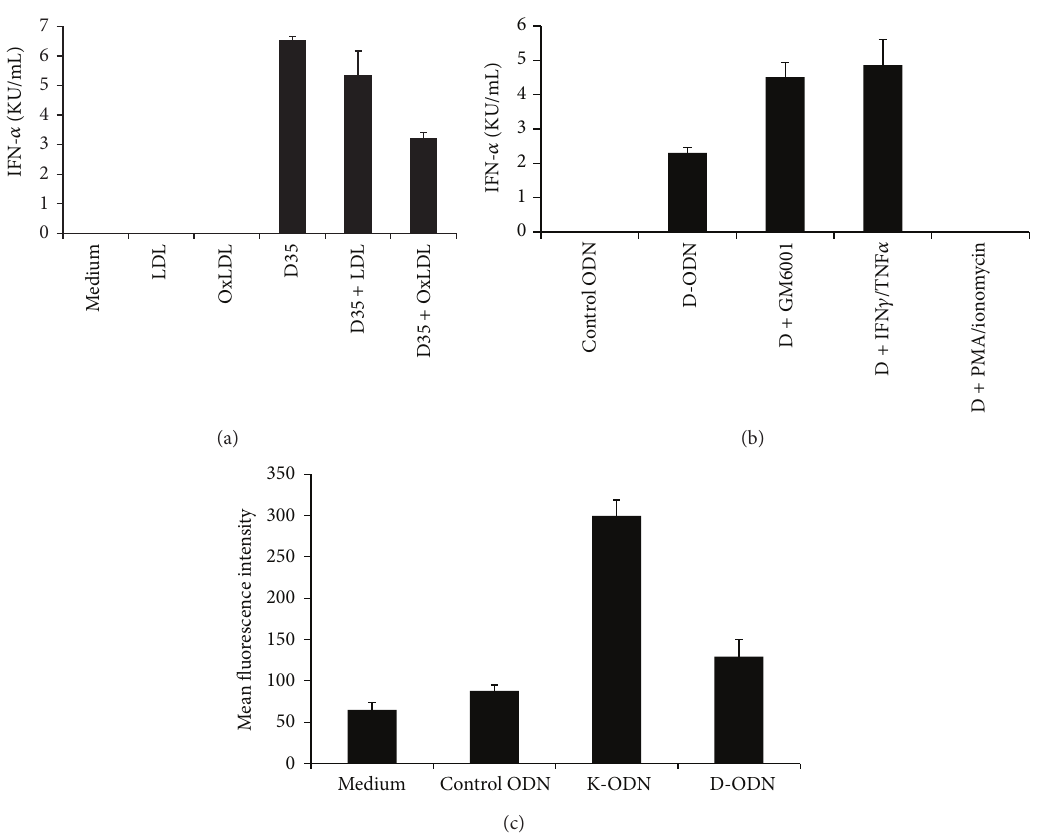
Figure 4: Oxidized LDL and recombinant IFN 𝛾 /TNF 𝛼 modify cytokine production induced by D-ODN. (a) Enriched pDCs (100,000 cells/well) were preincubated with LDL or OxLDL (10 𝜇 g/mL each) and then stimulated with 3 𝜇 M of D-ODN. Cytokine production was assessed from culture supernatants 24h later using ELISA. Average response of 3 different pDC preparations is shown (mean ± S.D). (b) Enriched pDCs were preincubated in the absence or presence of GM6001 (50 𝜇 M), recIFN 𝛾 /TNF 𝛼 (20 ng/mL each), or PMA/ionomycin (250 pg/mL/100pg/mL) for 30min at 37 ∘ C. Cytokine production was assessed from culture supernatants 24h later using ELISA. Average response of 3 different pDC preparations is shown (mean ± S.D). (c) PBMC (4 × 10 6 /mL) were preincubated in the absence or presence of 1 𝜇 M Control ODN, 1 𝜇 M K-ODN, or 3 𝜇 M D-ODN for 48 h. Cells were then fixed and stained for CXCL16 expression. MFI of CXCL16 stained cells ± S.D of 3 different donors is